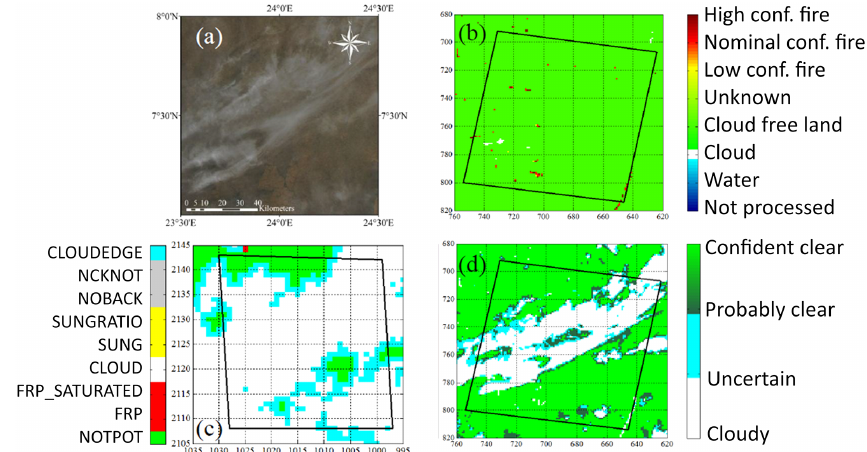
Figure 4. Simultaneous data collected by the Aqua MODIS and Meteosat SEVIRI instruments over a 1 ◦ × 1 ◦ region of the Central African Republic (CAR) at 12:00UTC on 11 January 2009. (a) 500m spatial resolution MODIS Aqua true colour composite, (b) MODIS fire mask retrieved from the coincident MYD14 active fire and thermal anomaly product, (c) the status flags (Table S1) retrieved from the coincident SEVIRI FRP-PIXEL quality file, and (d) the MODIS cloud mask retrieved from the coincident MYD35 MODIS cloud product. The MODIS true colour composite image has been reprojected into geographic coordinates and this area is shown boxed on the other products (shown in their native image coordinate systems). It is apparent that the geographically widespread, but somewhat transparent, cloud shown in the MODIS colour composite in (a) is widely detected by the MODIS MYD35 cloud mask (d) and by the adapted CMa used in the FRP-PIXEL products (c) . However, the MODIS cloud mask used in the MODIS fire product (b) is specified such that it does not detect such thin clouds and allows fires burning underneath to remain detectable. Far less cloud can be seen to be detected by this mask than by either of the other two masks. The figure is adapted from Freeborn et al. (2014a), who go on to confirm the very strong sensitivity of the SEVIRI CMa of Derrien and Le Gleau (2005) to cloud, compared to that of the MODIS active fire product cloud